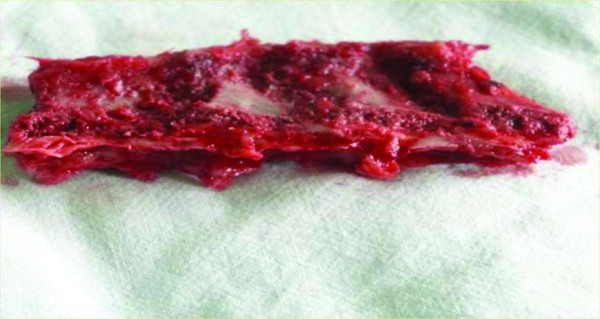
The en bloc removed lamina, note the nodular ossified ligamentum flavum.